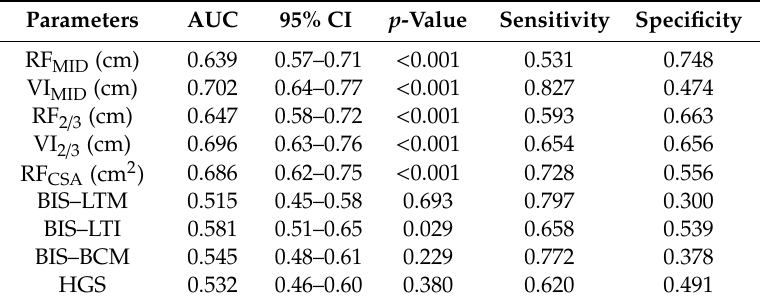
Table 3. ROC analysis of US, BIS, and HGS for PEW risk.